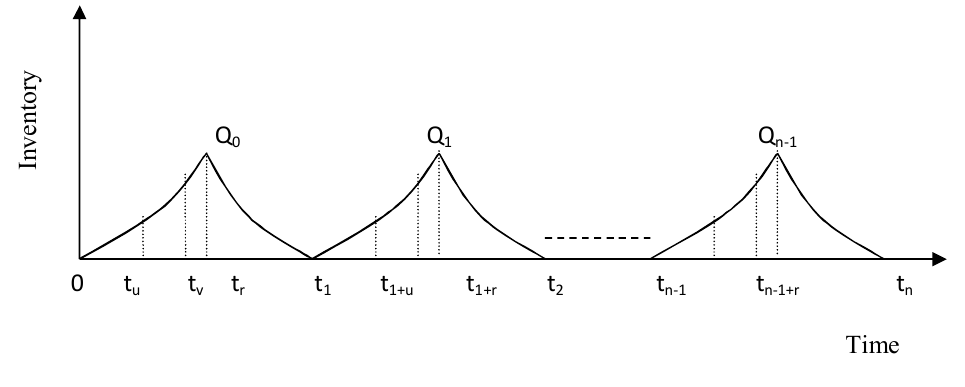
Fig.1. Graphical representation of the system for Case